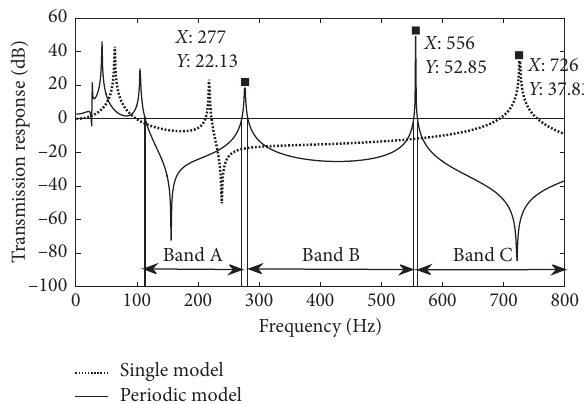
Figure 15: Transmission response for the curved beam with single model and eight-periodic